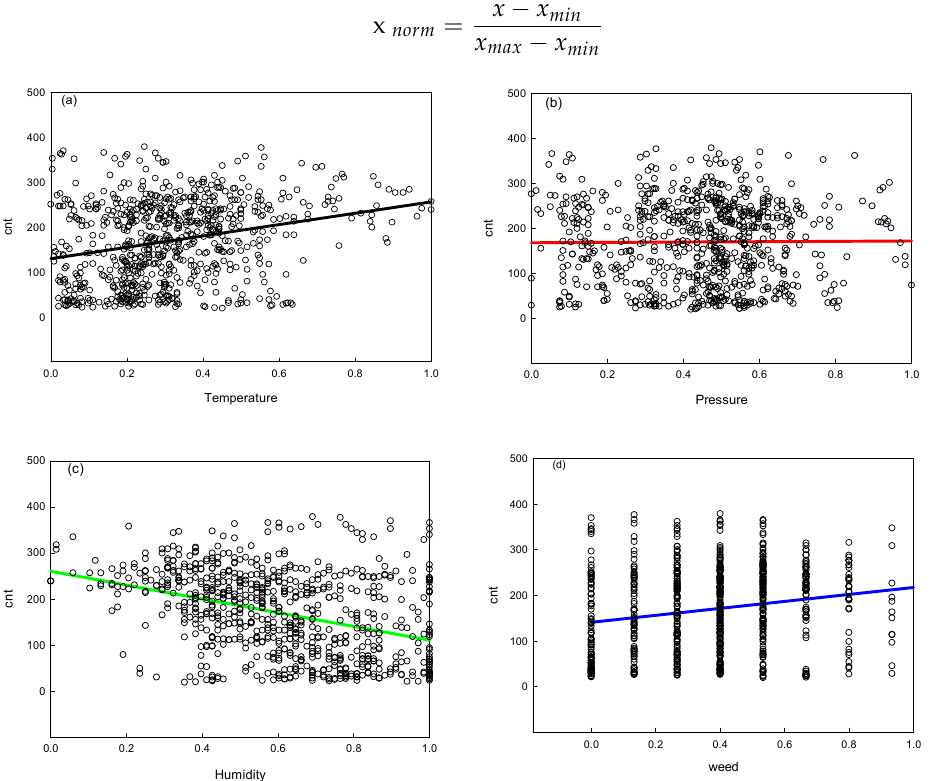
Figure 6. The regression trend for the weather features to cnt. ( a ) the correlation between the parking occu-pancy rate and the temperature; ( b ) the correlation between the parking occu-pancy rate and the pressure; ( c ) the correlation between the parking occu-pancy rate and the humidity; ( d ) the correlation between the parking occu-pancy rate and the wind